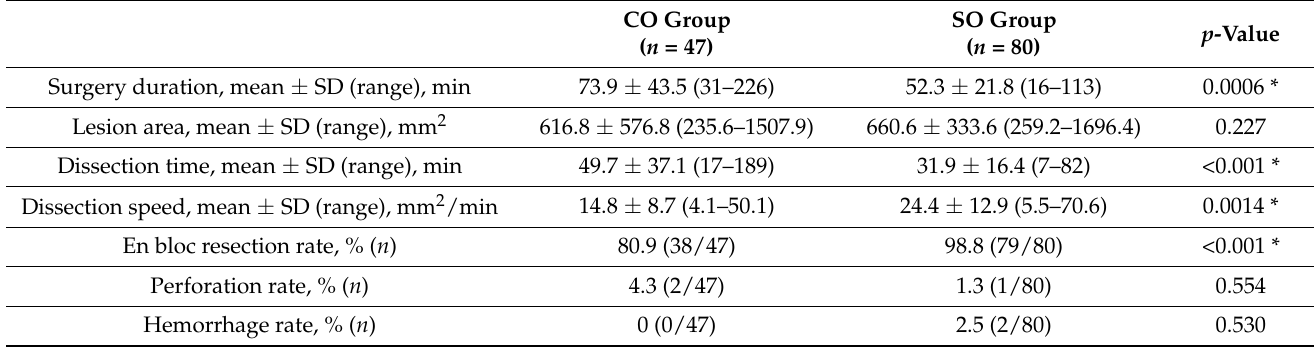
Table 2. Overall outcomes.